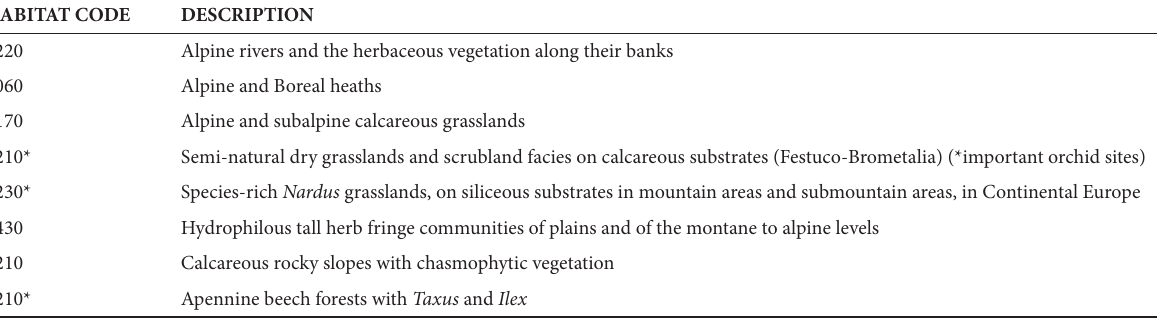
Table 1. EU Annex I codes of the habitat types present in the study area, with relative description (with asterisk the priority habitats; European Commission 2013.